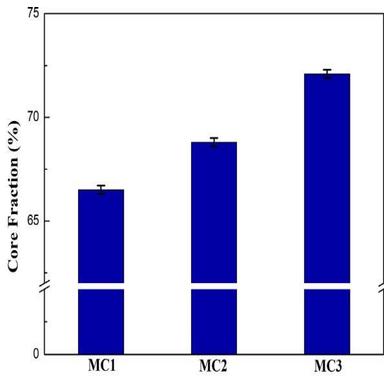
Core fraction of microcapsules with different shells.